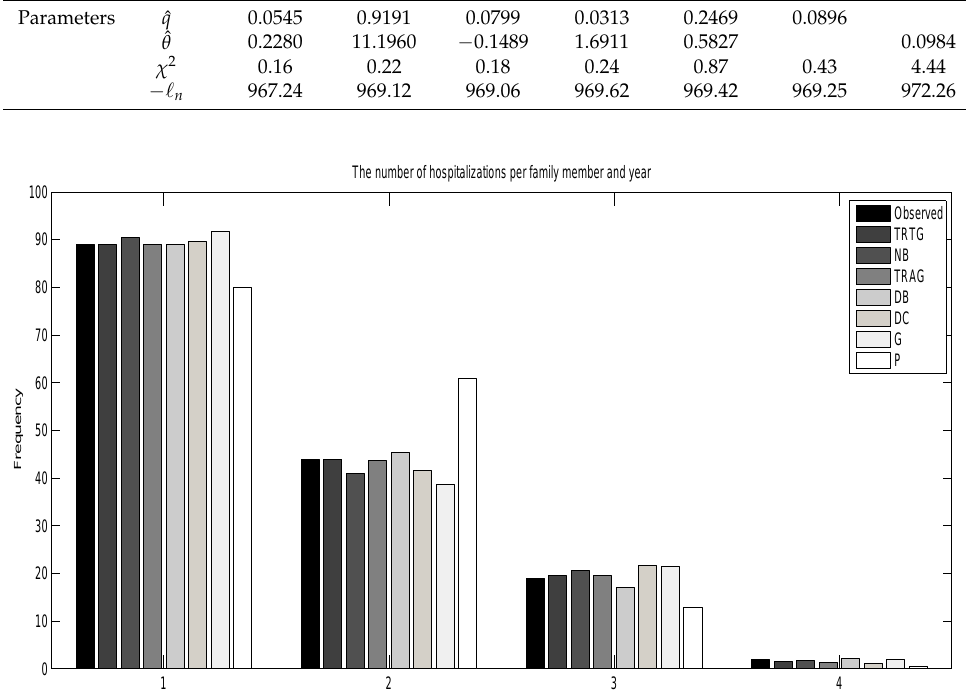
Figure 5. Observed and fitted distributions for third